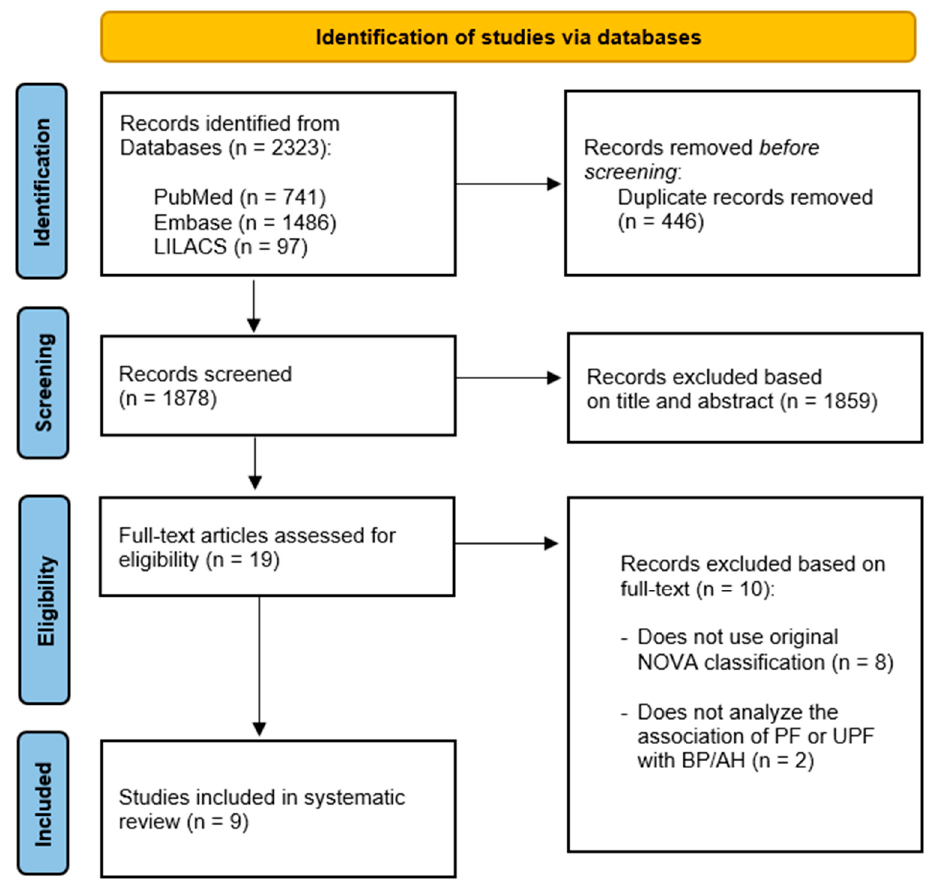
Figure 1. PRISMA flowchart of the included studies.